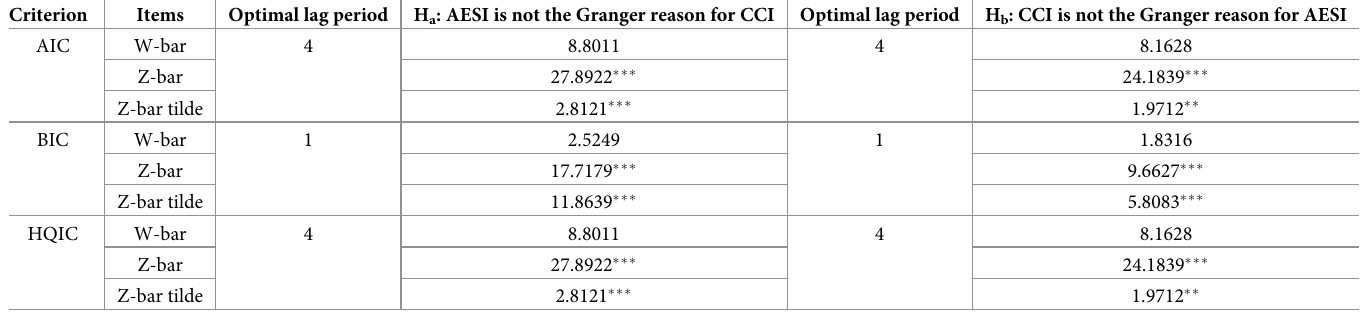
Table 2. Results of panel Granger causality test (PGCT) between average export similarity index (AESI) and commodity concentration index (CCI).